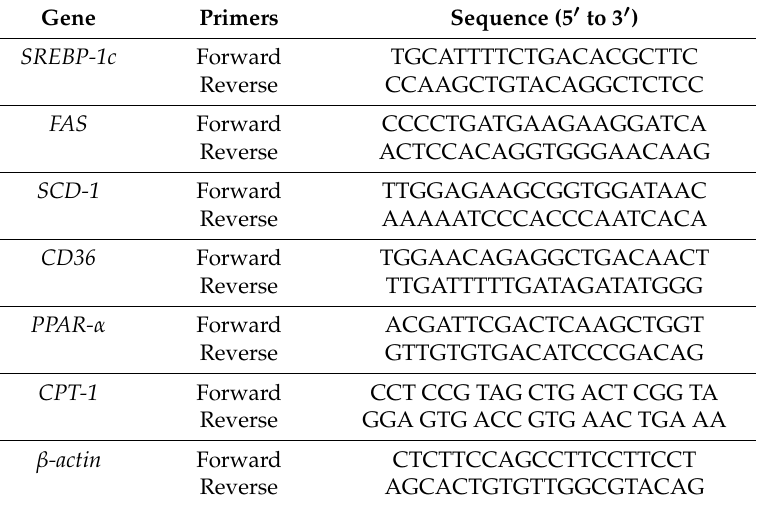
Table 1. Primer sequences used in quantitative real-time